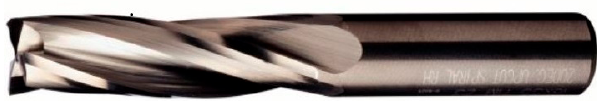
Figure 5. Mill cutter used for wood milling process at the SCM Tech Z5 milling centre.